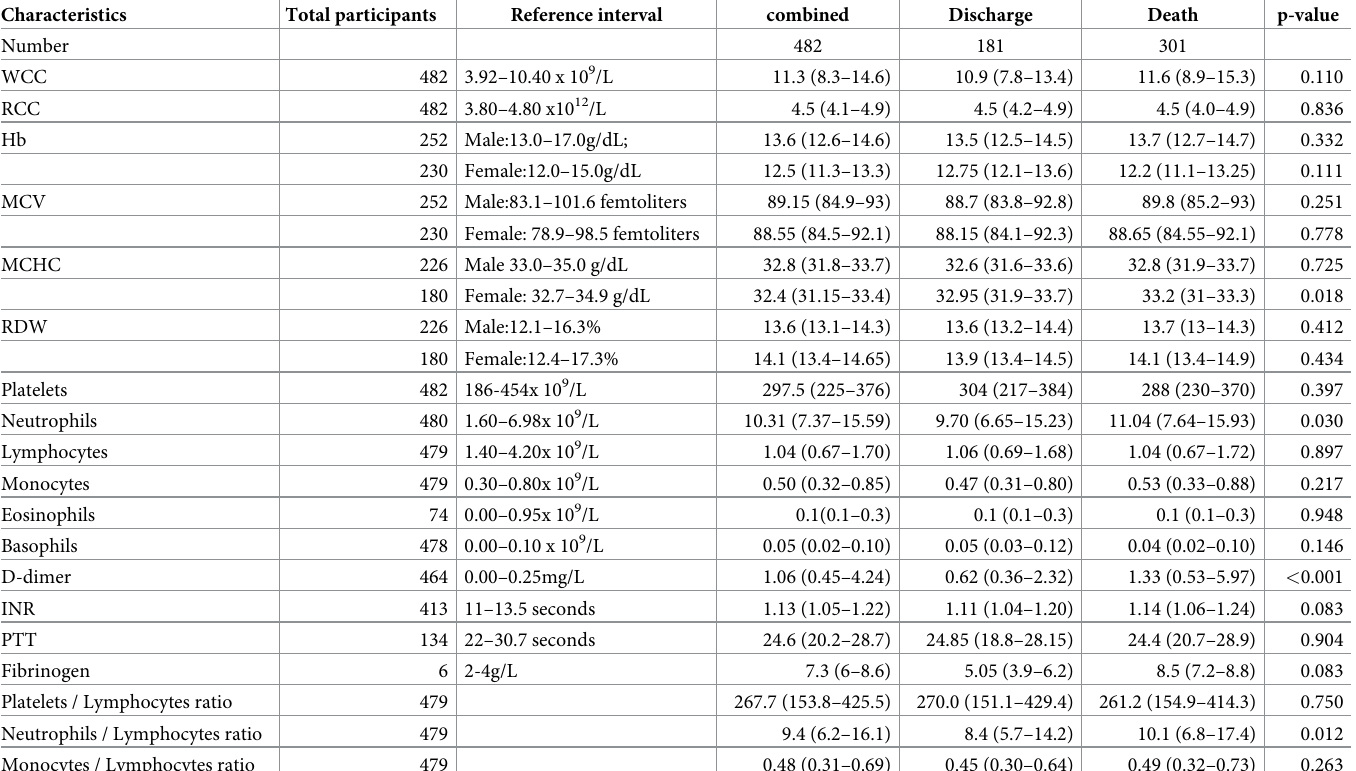
Table 2. Baseline haematological characteristics of COVID-19 patients admitted to the ICU. Characteristics